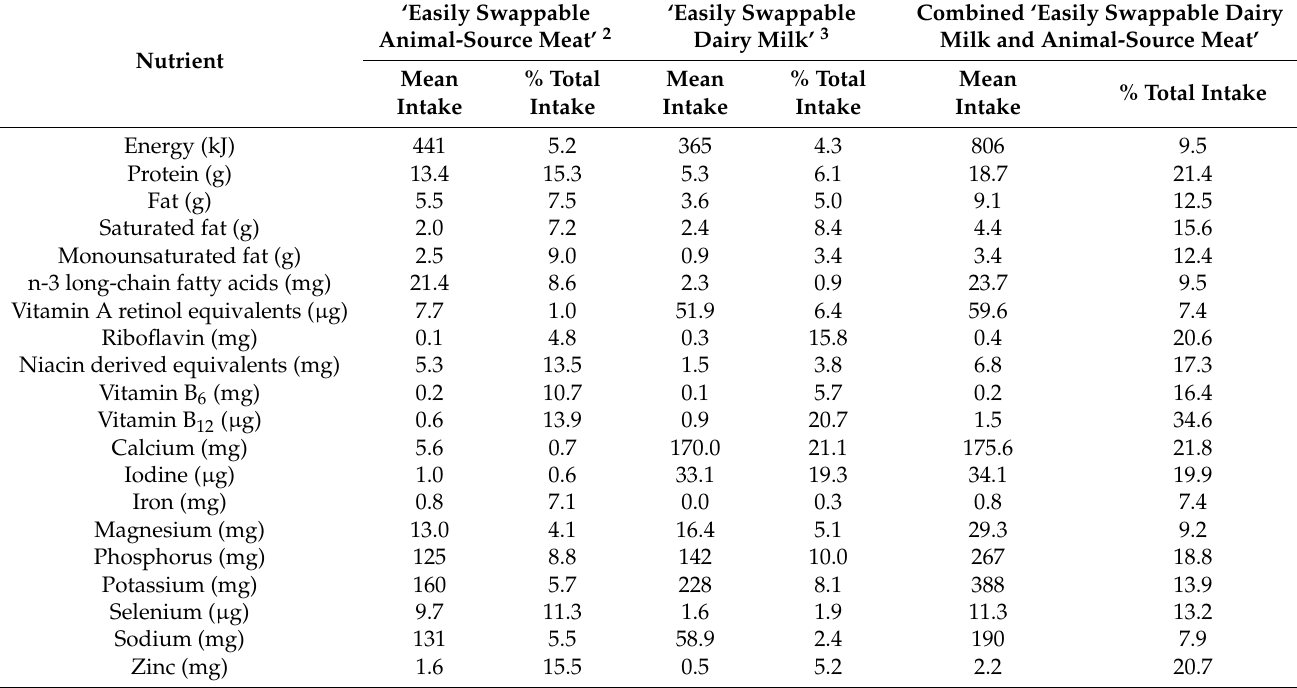
Table 2. ‘Key Nutrients’ 1 supplied by ‘Easily Swappable Dairy Milk and Animal-Source Meat’ in the Australian National Nutrition and Physical Activity Survey 2011–2012 (for persons aged 2 years and